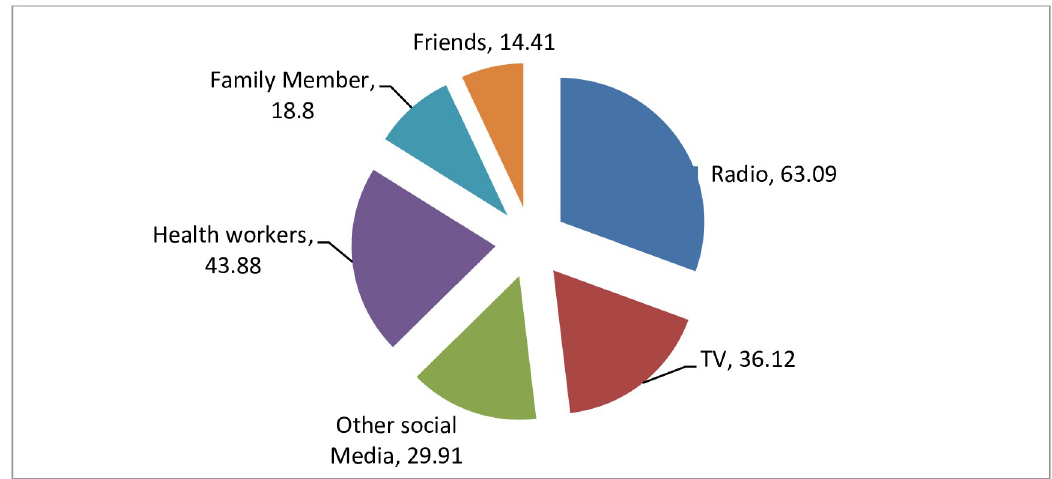
Fig 4. Percentage of source of information, Oromia region, Ethiopia, September 2020 to March 2021.